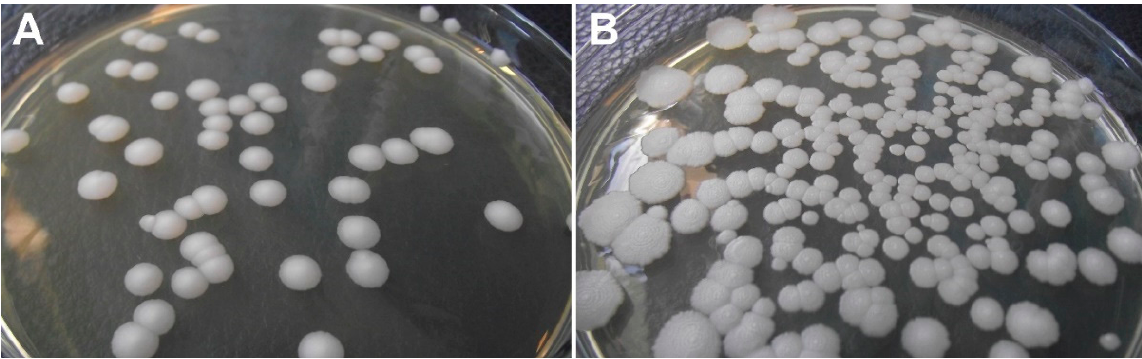
Figure 2. Colonies of P. blaschkeae ( A ) and P. bovis ( B ) microalgae strains grown on Sabouraud agar medium.